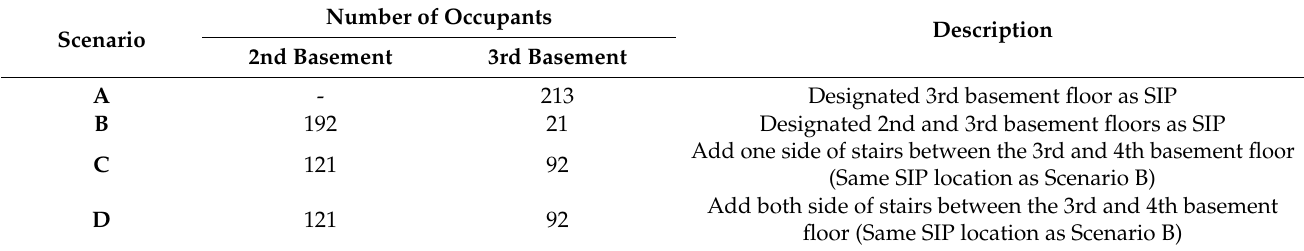
Table 6. Location of Shelter in Place and Scenario description.